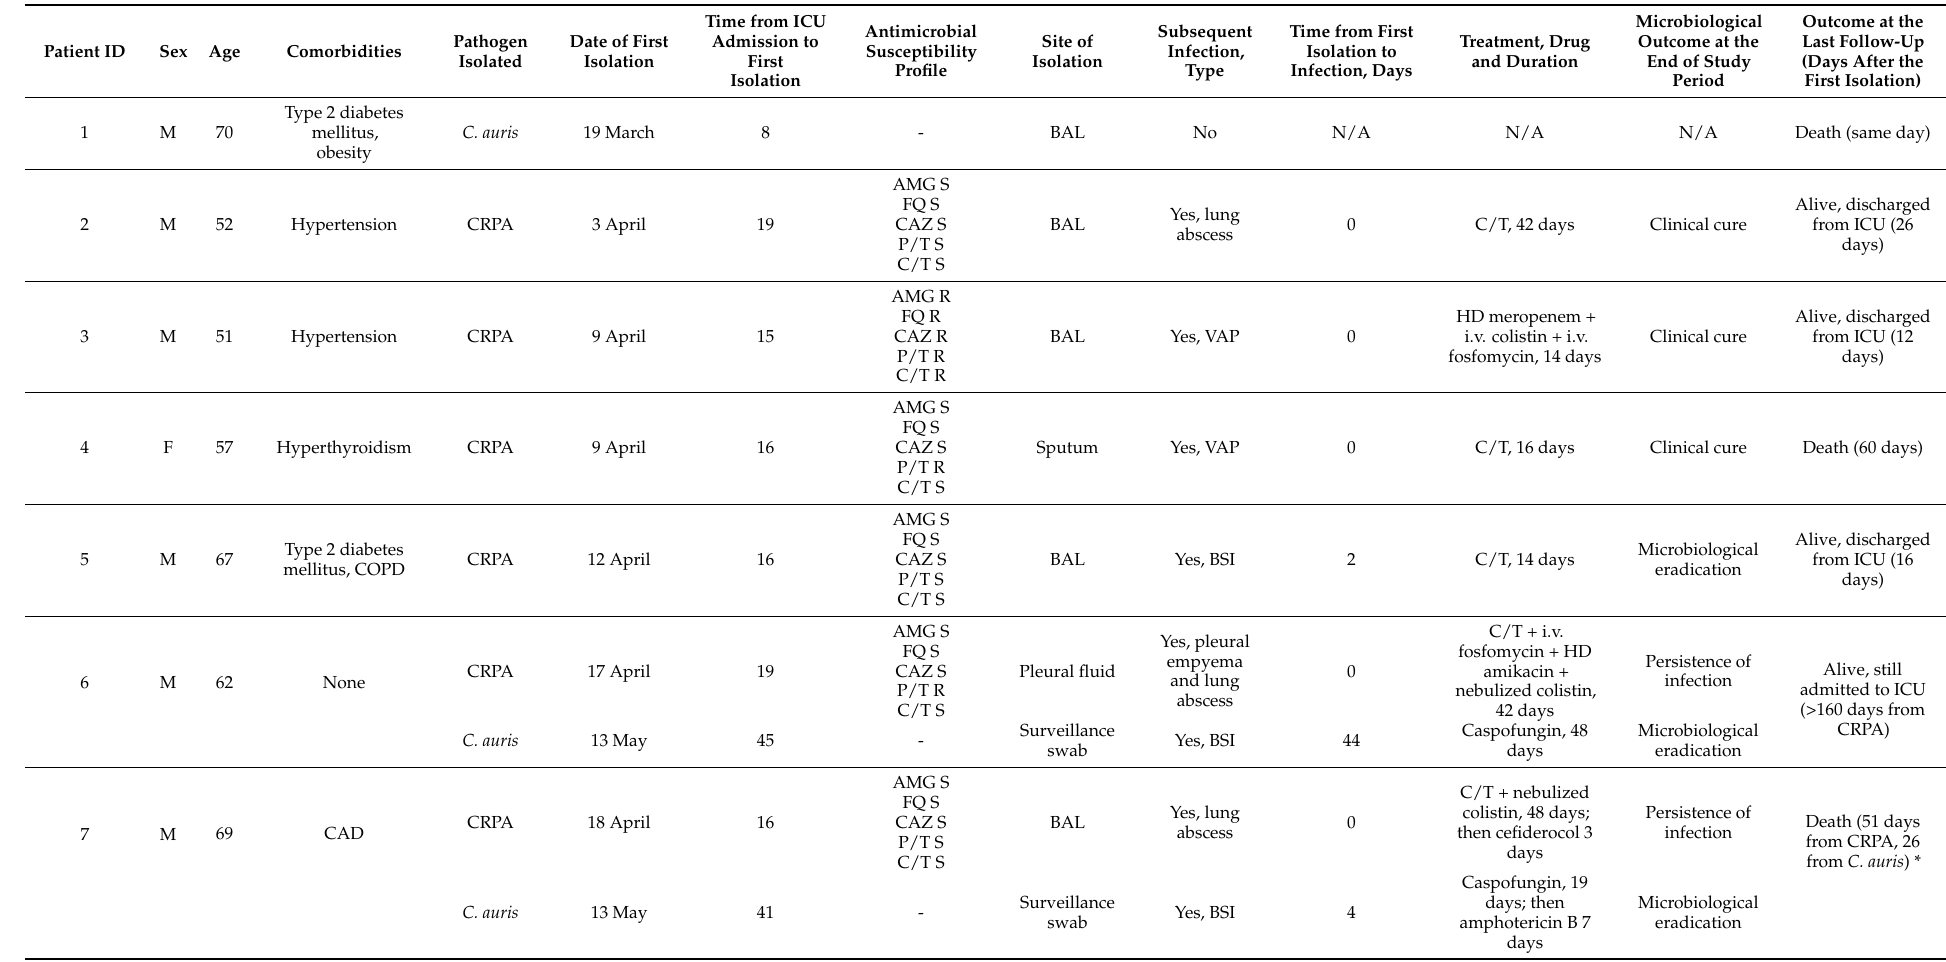
Table 1. Demographics, comorbidities, sites of drug-resistant organisms’ colonization/infection and outcomes of the 14 patients described in the